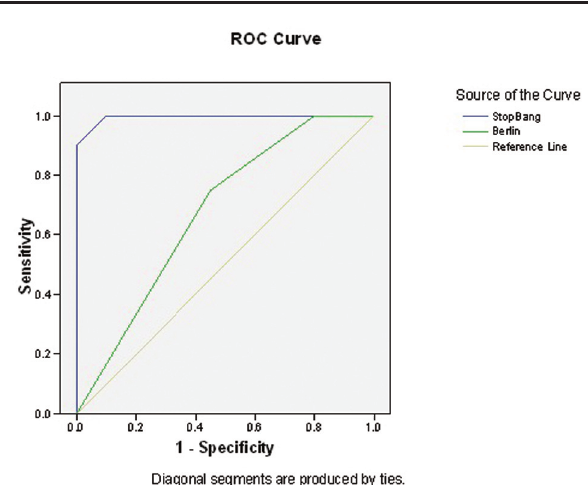
Receiver operating characteristic (ROC) curve analysis of STOP- BANG questionnaire and Berlin questionnaire for diagnosis OSAHS patients. OSAHS, obstructive sleep apnea hypopnea